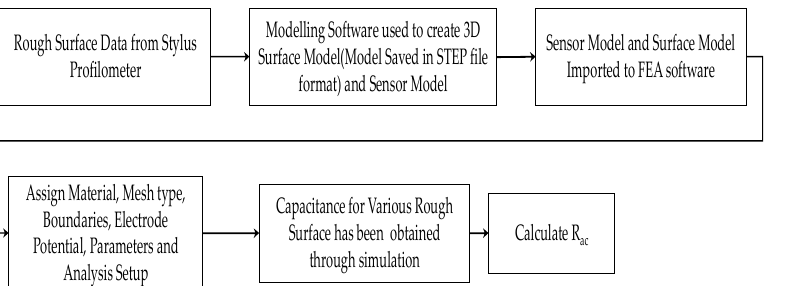
Figure 11. Simulation steps involved in capacitance sensor with surface (flat and rough) model.